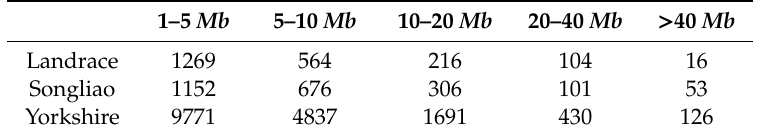
Table 1. Summary of the number of runs of homozygosity (ROH) in di ff erent categories in each